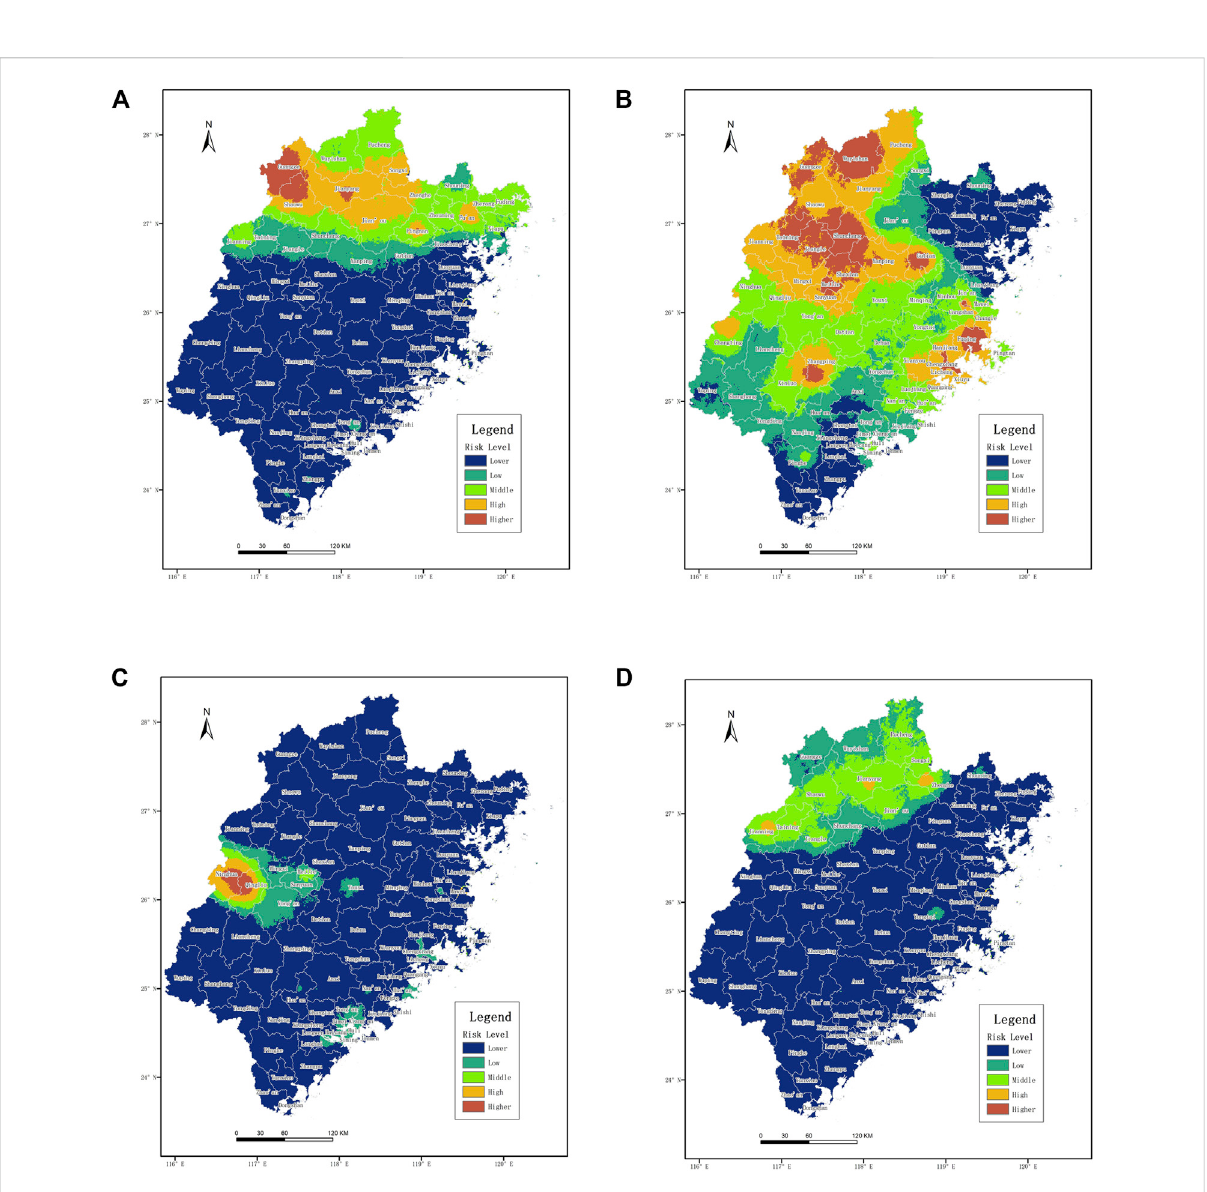
FIGURE 7 Spatial distribution pattern of the comprehensive risk of four non-typhoon rainstorm cases. (A) 19980619-0624. (B) 20100614-0626. (C) 20150519-0520. (D) 20160505-0510.